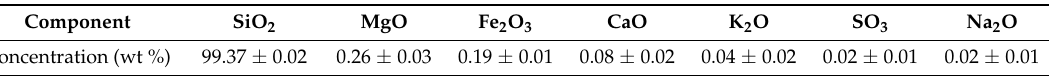
Table 2. X-ray Fluorescence (XRF) results of dislodged